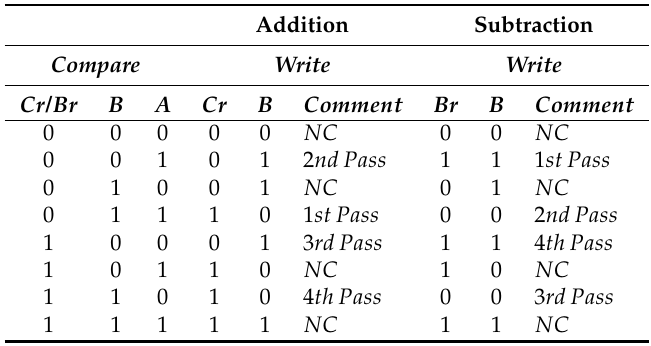
Table 2. LUTs for addition and subtraction.